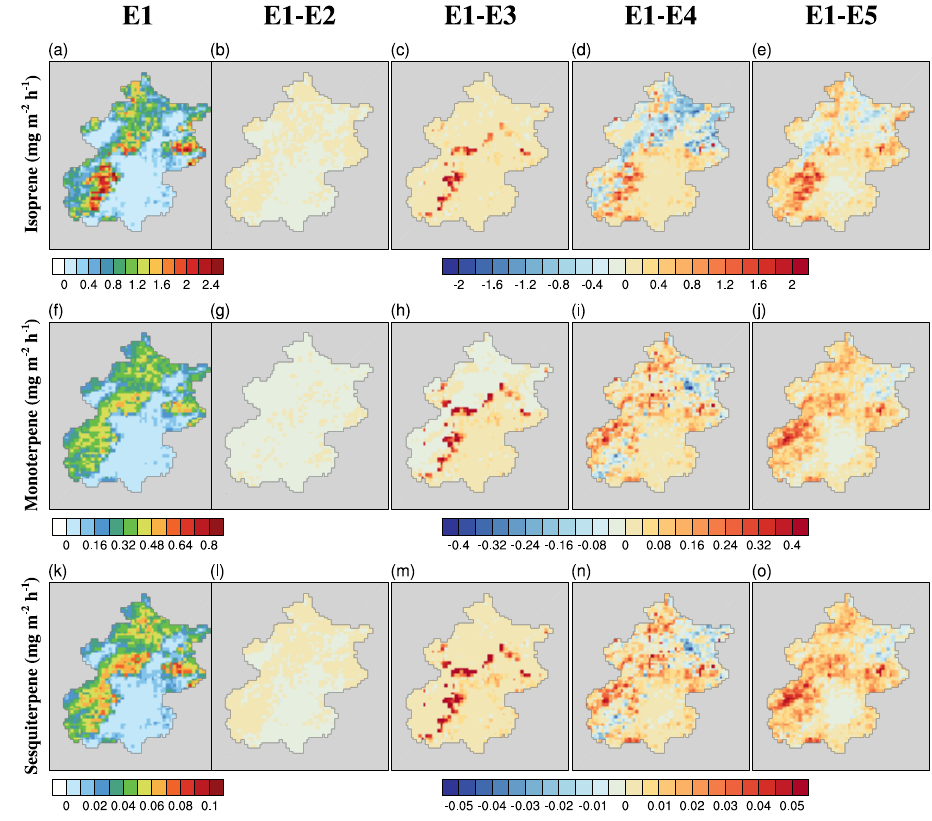
Figure 7. The spatial distribution of average emissions of the three main VOC species in